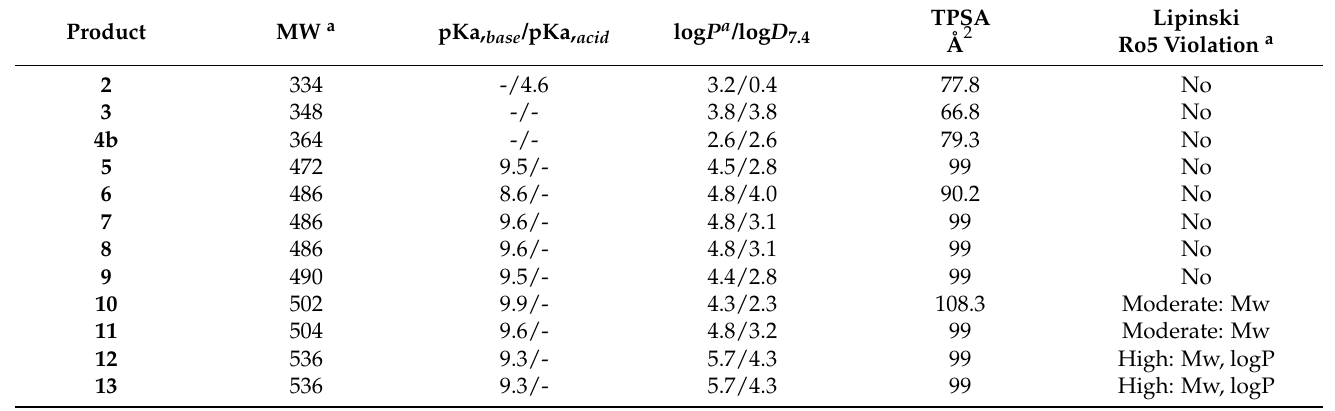
Table 2. Predicted physicochemical parameters of steviol-based aminotriols using the ACD/Labs Percepta software package. MW: molecular weight, TPSA: topological polar surface area. Lipinski’s rule of 5 (Ro5) for estimation of drug-like